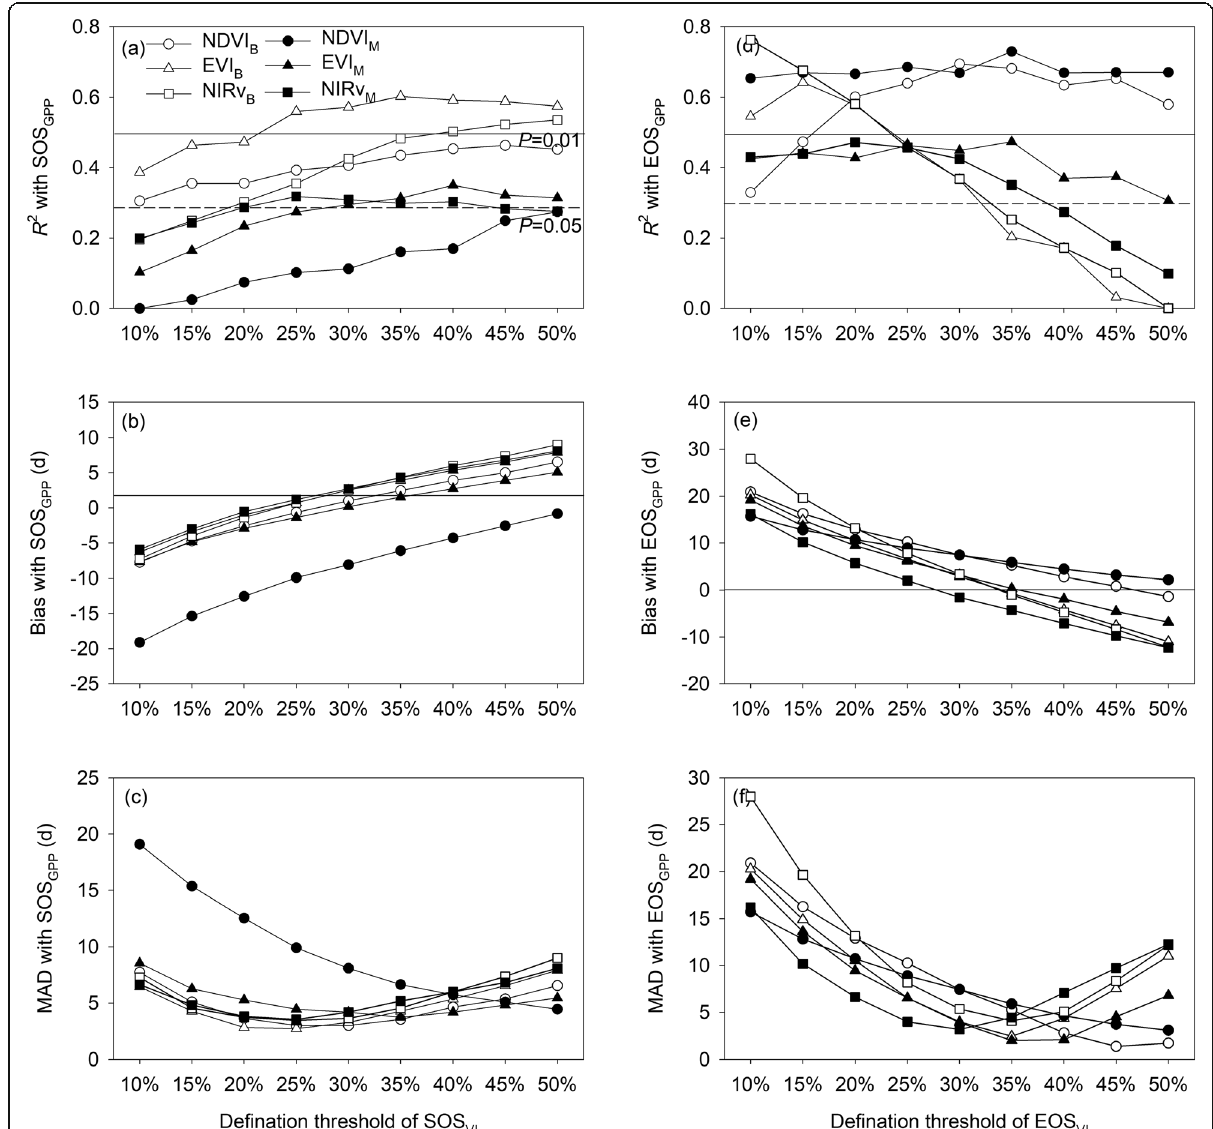
Fig. 5 Determination coefficient ( R 2 ) of the regression, mean bias and mean absolute deviation (MAD) of the phenology estimated from vegetation indices (VI) against that from gross primary production (GPP). SOS: start of growing season, EOS: end of growing season. NDVI B : broadband normalized difference vegetation index, EVI B : broadband enhanced vegetation index, NIRv B : broadband near-infrared albedo of vegetation, NDVI M : MODIS normalized difference vegetation index, EVI M : MODIS enhanced vegetation index, NIRv M : MODIS near-infrared reflectance of